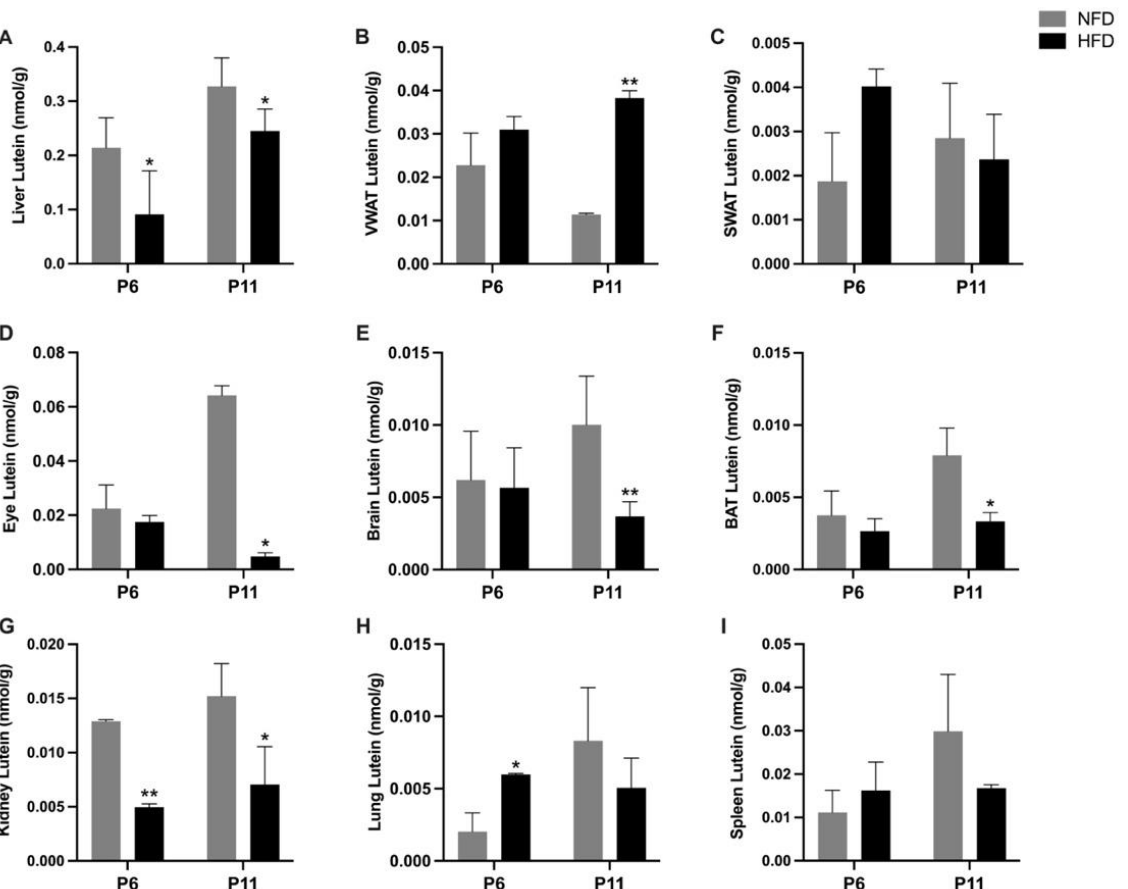
Figure 5. Concentration of lutein in the liver ( A ), visceral white adipose tissue ( B ), subcutaneous white adipose tissue ( C ), eye ( D ), brain ( E ), brown adipose tissue ( F ), kidney ( G ), lung ( H ), and spleen ( I ) of rat pups at postnatal day 6 and postnatal day 11. Bars show mean ± SD, n = 7 per group. Significant difference between groups was indicated by *, p < 0.05 and **, p < 0.01. At P2, tissue samples were not adequate for analysis, and therefore, data are